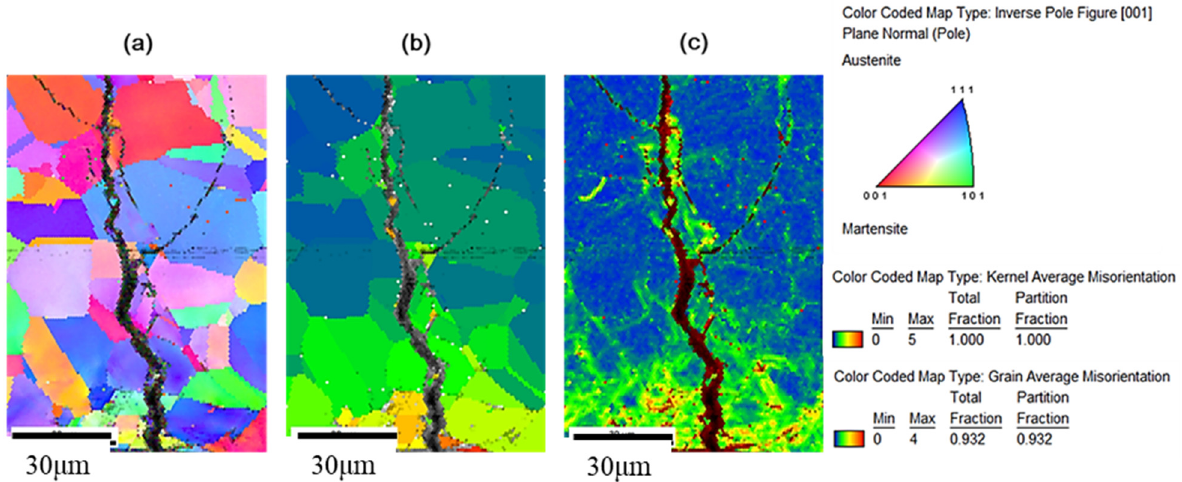
Figure 13. ( a ) Crystal orientation, ( b ) GAM, and ( c ) KAM maps by EBSD analysis of the specimen with 4 g/m 2 of sea salt deposited on the surface after testing at 300 MPa tensile stress for 1500 h at 45 °C and 45% relative humidity.